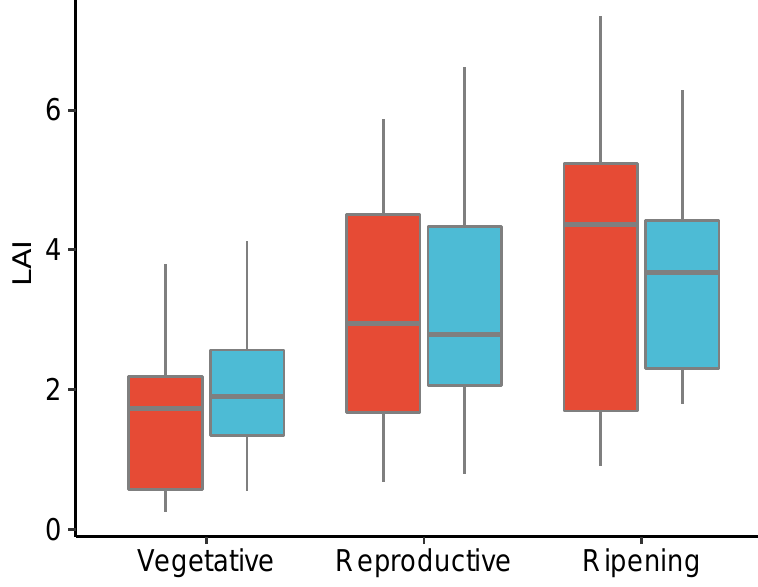
Figure 2. Boxplot of measured leaf area index